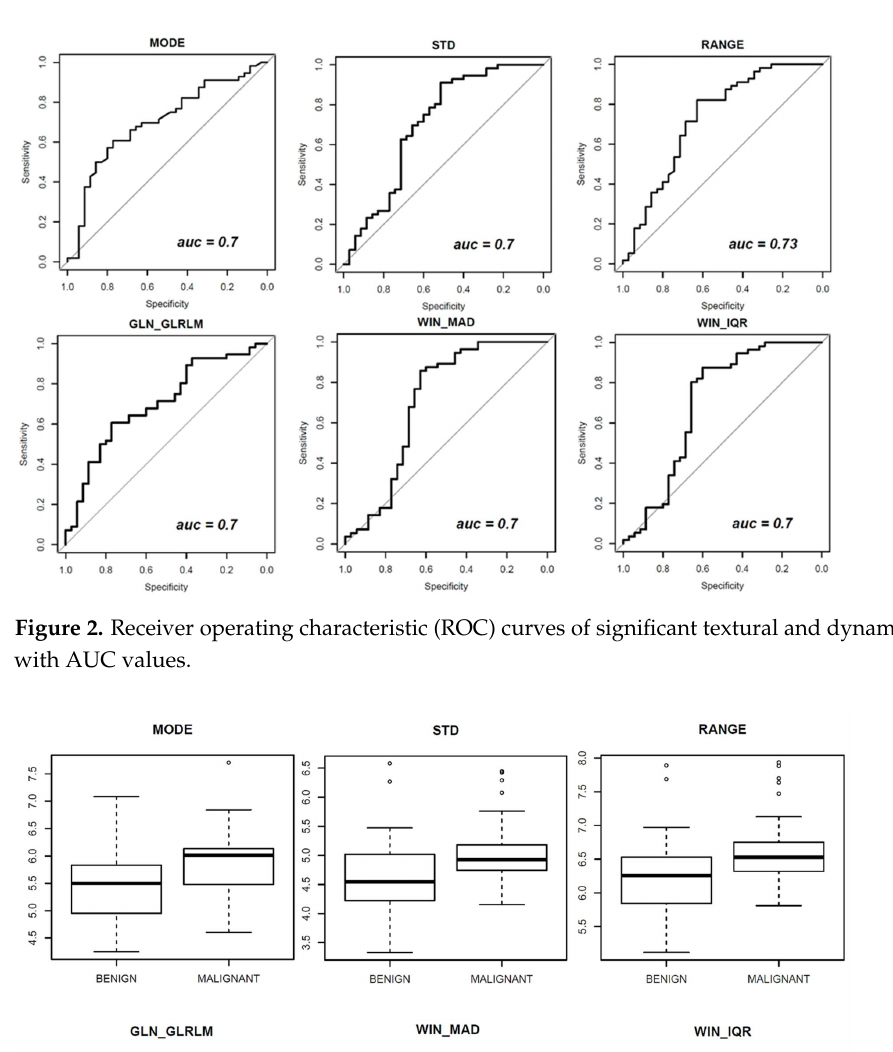
surface (number of voxels belonging to the lesion